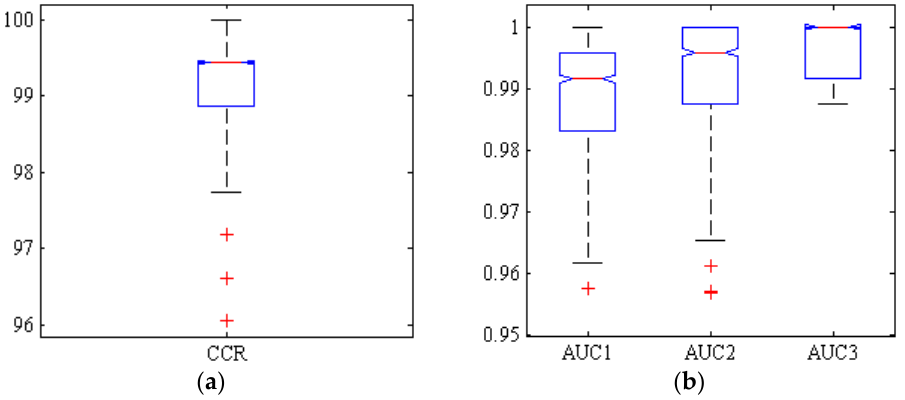
Figure 8. Boxplots of ( a ): the correct classification rate (CCR) and ( b ): AUC reached by ensemble ANN-PSO / ACO / HS-MV classifier, for Adel (AUC1), Arman (AUC2) and Azad (AUC3) chickpea ( Cicer arietinum L.) varieties (1000 uniform random simulations, test set).